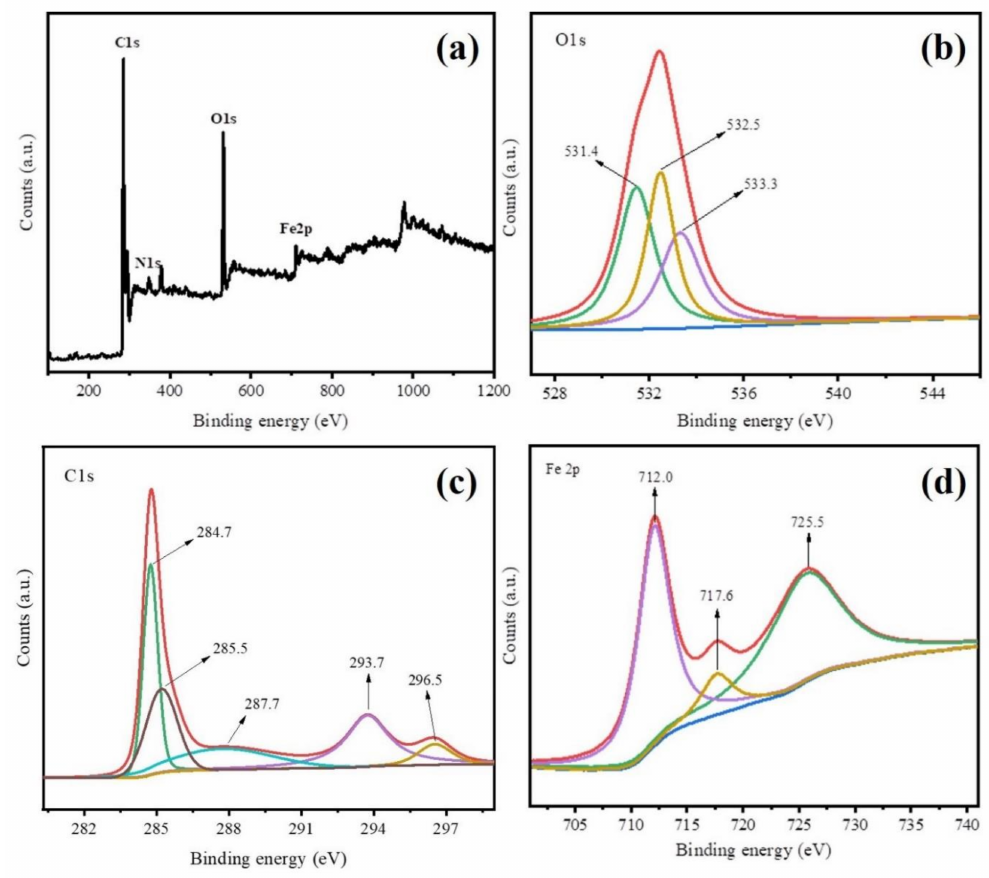
Figure 5. X-ray photoelectron spectroscopy (XPS) spectra of Fe@BC ( a ) XPS survey of, ( b ) O 1 s, ( c ) C 1 s, and ( d ) Fe